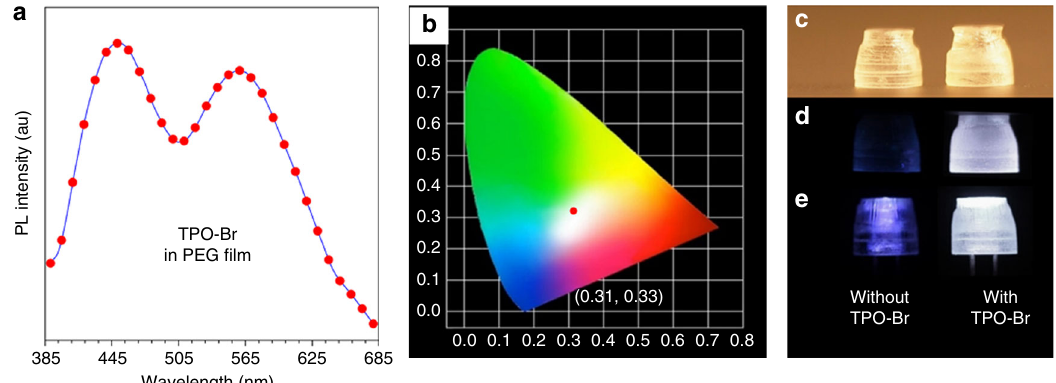
Fig. 6 White light emitters in 3D printing. a PL spectra and b CIE 1931 coordinates of prompt emission of the PEG fi lm containing TPO-Br (2%, m/m). Photographs of 3D printed lampshades without (left) and with (right) TPO-Br taken under c daylight, d 365 nm UV light irradiation, and e UV-LED lamps. The size of lampshades is 8.2 × 8.2 × 9.2 mm